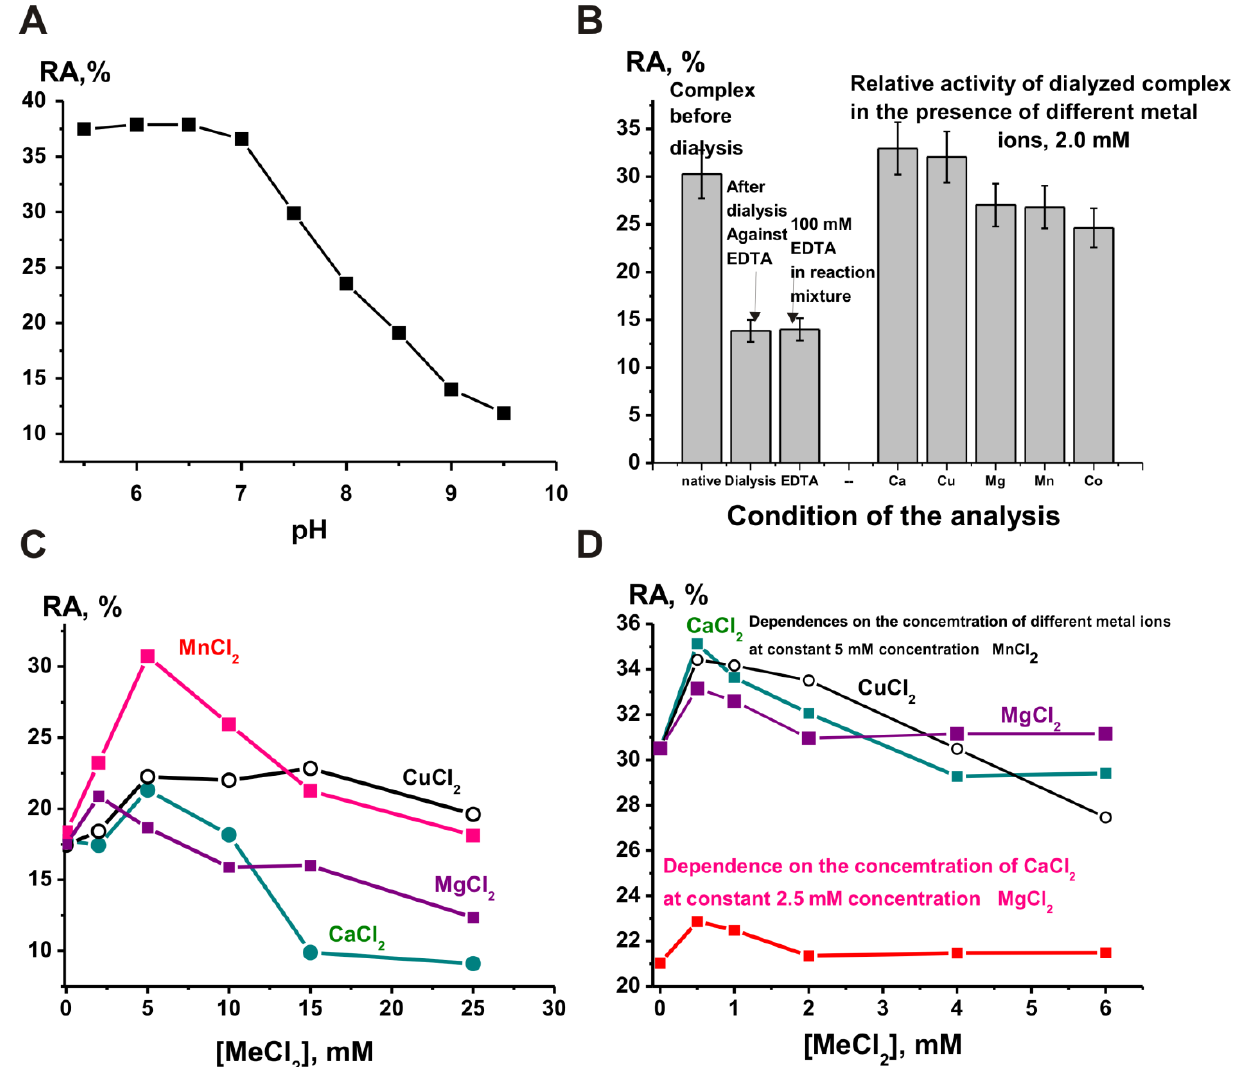
Figure 5. Dependence of the DNA efficiency of hydrolysis by a stable complex (0.015 mg/mL) on the pH of the reaction mixture ( A ). Effect of the complex preincubation with EDTA, addition of EDTA in reaction mixture, and different metal ions (2.0 mM) on the activity of a complex dialyzed against EDTA ( B ). Dependence of the efficiency of DNA hydrolysis by the complex dialyzed against EDTA on concentrations of different metal ions ( C ). Dependence of the DNase activity of the complex on the concentration of CaCl 2 at a constant optimal concentration of MgCl 2 (2.5 mM), as well as the concentration of chlorides of different metals (Ca, Cu, and Mg) at a fixed concentration (5.0 mM) of MnCl 2 ( D ) .